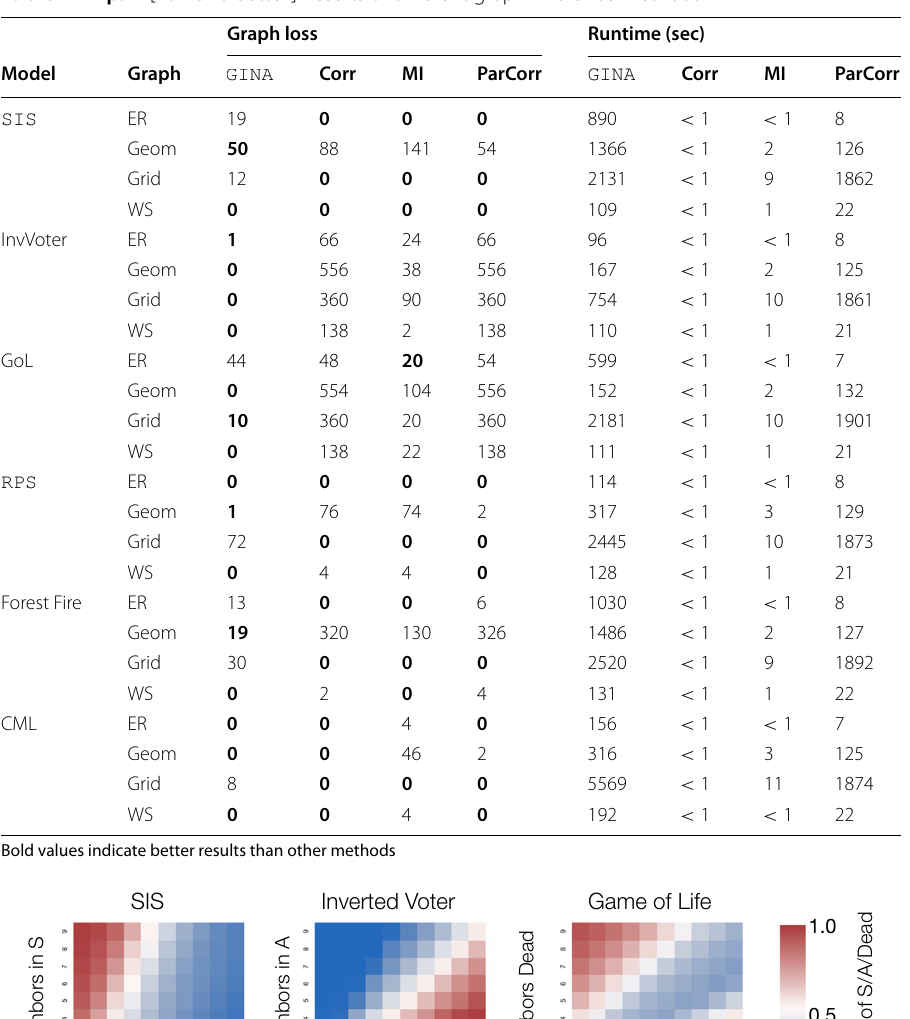
Table 1 Exp. 2 : [Lower is better.] Results of different graph inference methods